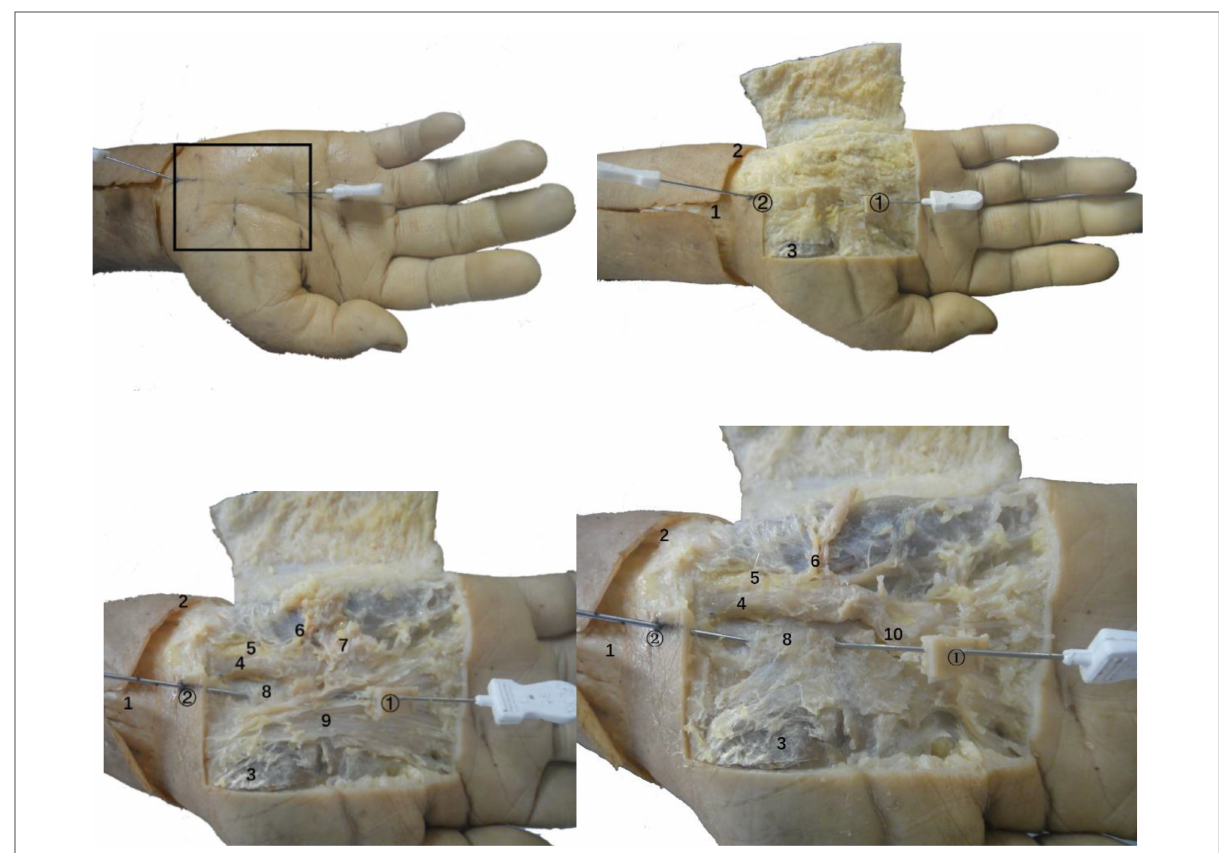
FIGURE 11 Anatomical view of the needle-knife release technique guided by ultrasound. 1. Palmar longus tendon; 2. Proximal transverse carpal striae; 3. Abductor pollicis brevis; 4. Ulnar artery; 5. Ulnar nerve; 6. Super fi cial branch of ulnar nerve; 7. Palmaris brevis; 8. Transverse carpal ligament;